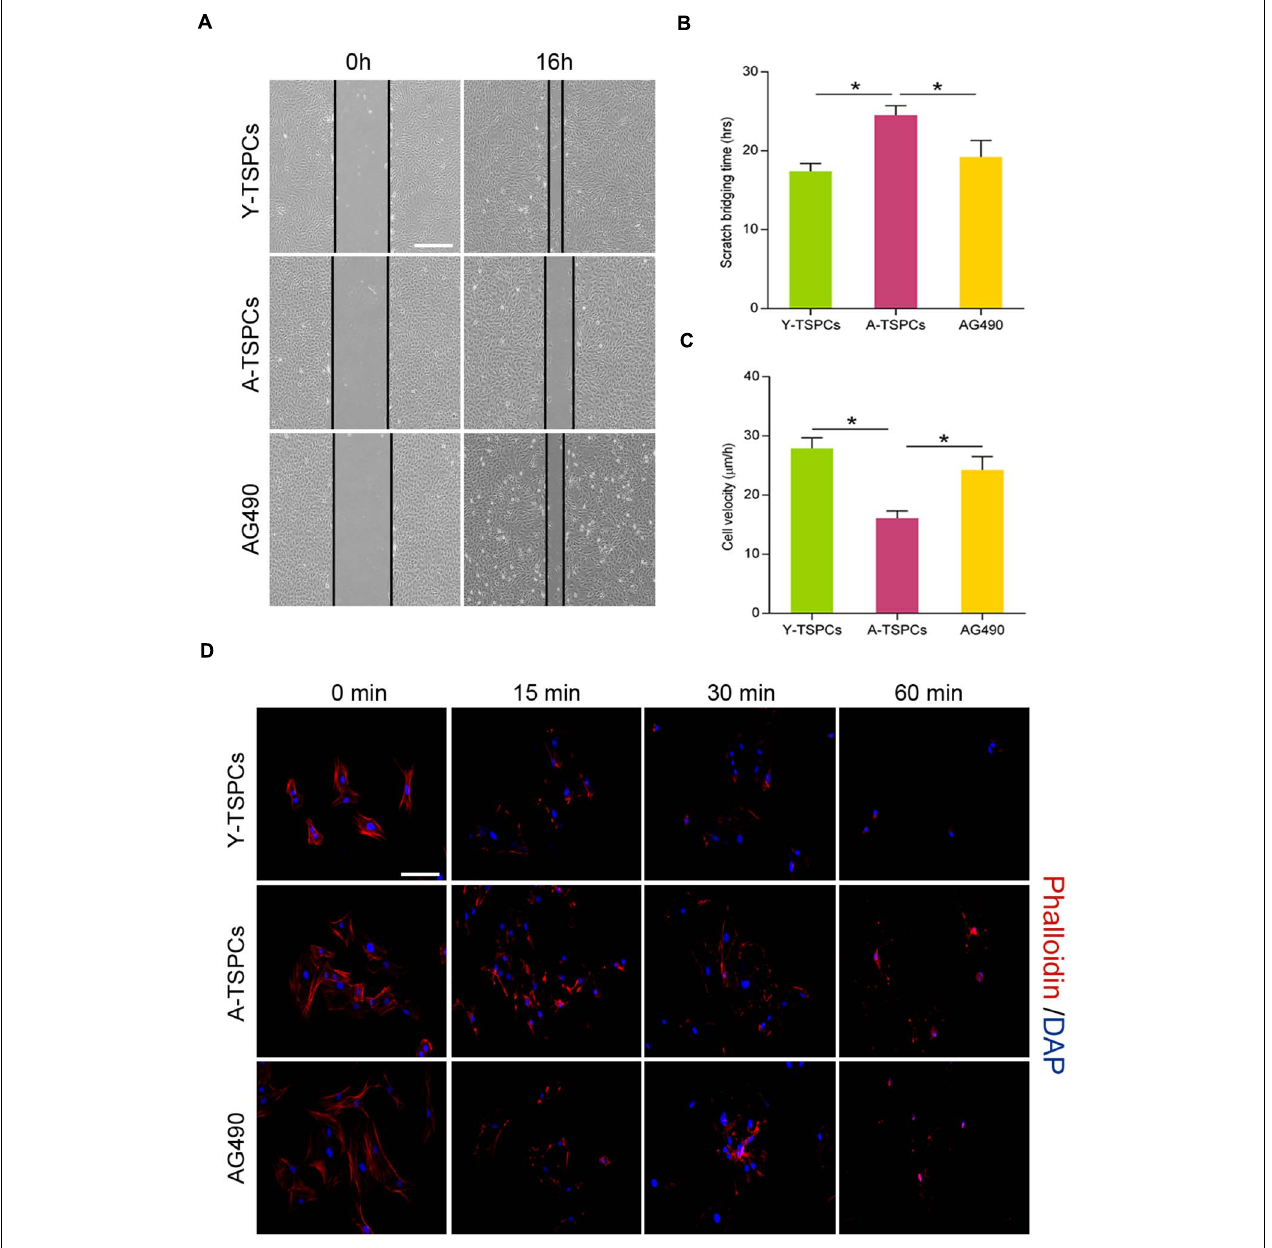
FIGURE 6 | AG490 enhances aged TSPC migration and actin dynamics. (A) Representative scratch assay of young, aged, and aged AG490-treated TSPCs. Scale bar: 200 µ m. (B , C) TSPC migration rate was calculated by scratch bridging time and cell velocity. (D) Phalloidin staining for F-actin in young, aged, and aged AG490-treated TSPCs at each time point after latrunculin A treatment. Scale bar: 20 µ m. * P < 0.05 compared with the young or aged